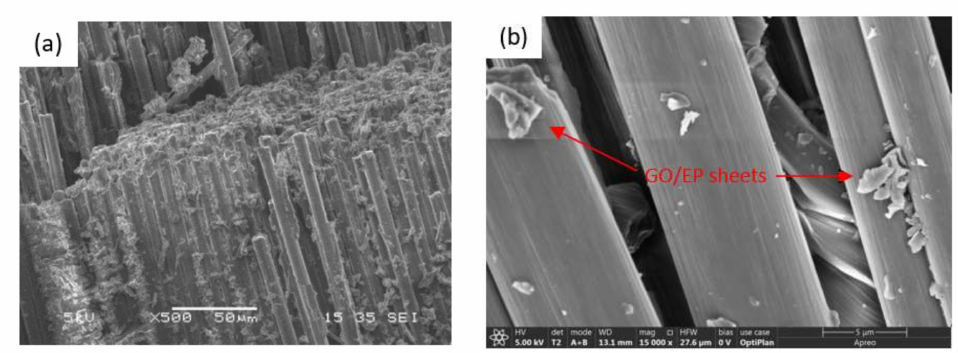
Figure 5. SEM images of CF-GO/EP composites ( a ) 500 × , ( b ) 15,000 × .